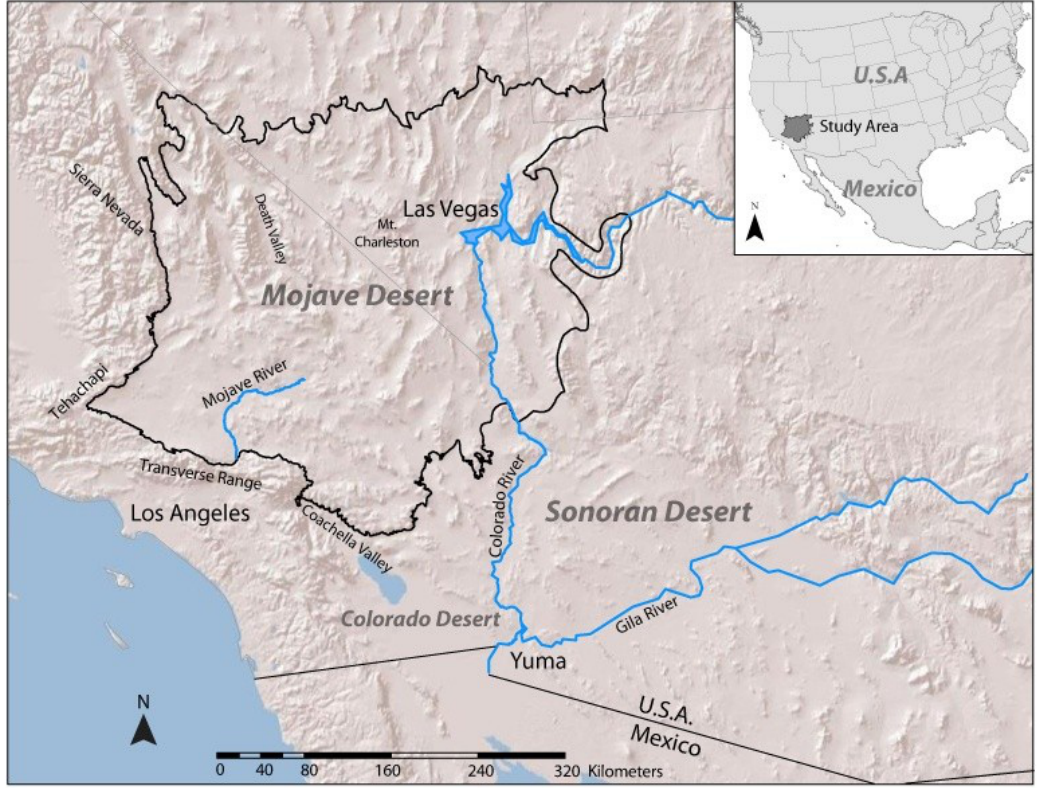
Figure 1. Mojave Desert study region including major geographic